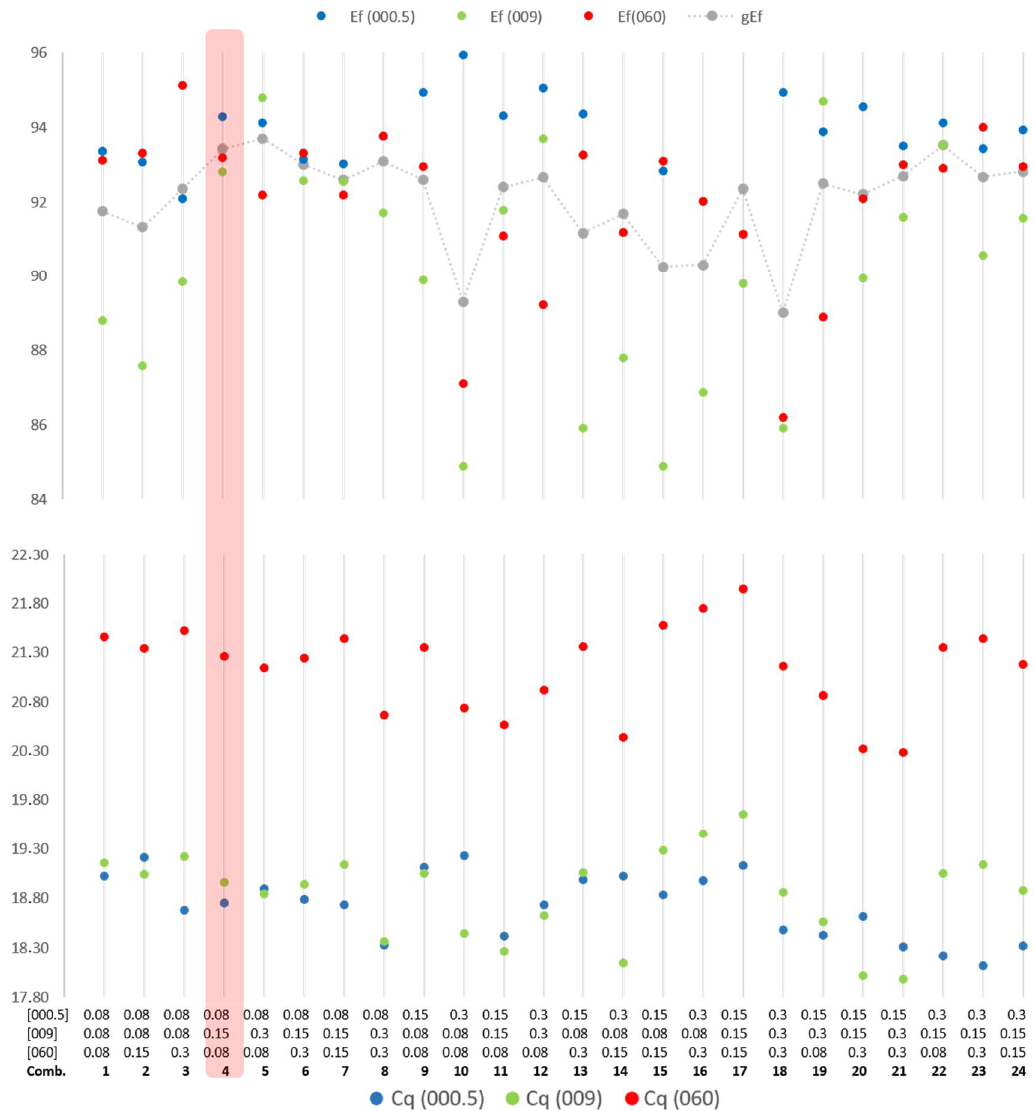
Figure 2. Graphical presentation of mPCR performance using different primers concentrations ([m000.5], [m009], [m060]) The grey dots are joined together (therefore not representing a trend line) to illustrate the variation in average efficiency. All combinations of variable primers and probes concentrations that generated ampli- fication efficiencies below 90% for the three systems, or at least for one, were excluded.